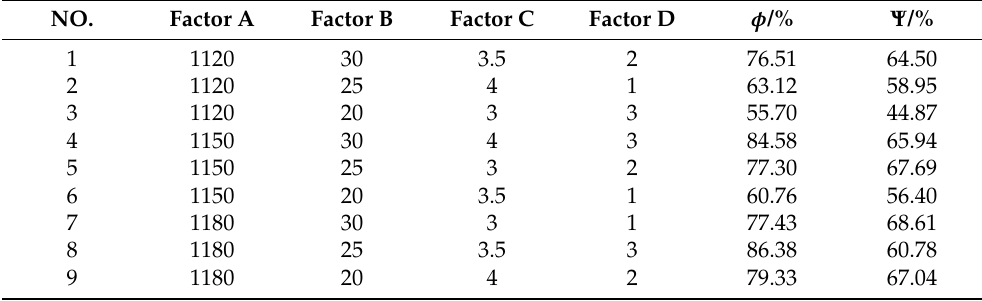
Table 5. Orthogonal test results.